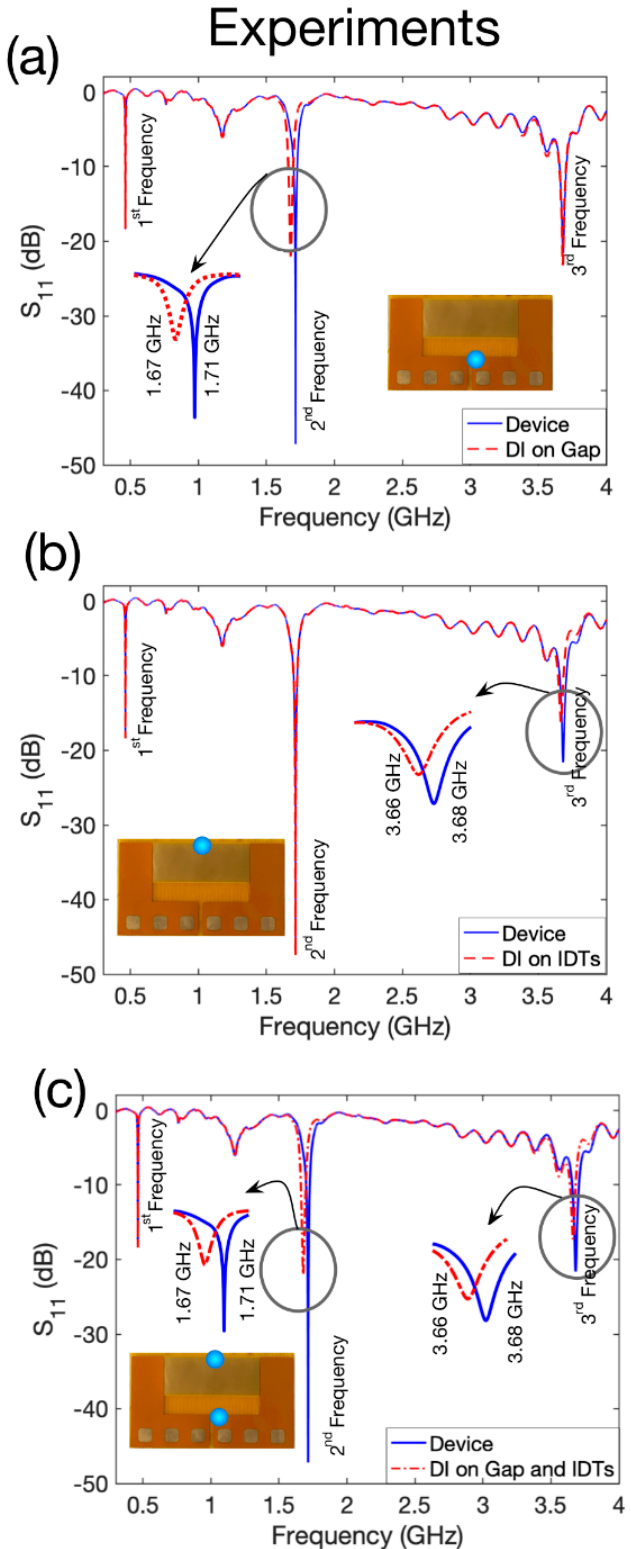
Figure 3. Experimental characterisation of the fabricated device ( a ) when a DI droplet is loaded on the gap as is shown in the inset, ( b ) when the DI droplet is loaded on the IDTs as is shown in the inset, ( c ) when the DI is loaded on the gap and also on the IDTs as is shown in the inset.